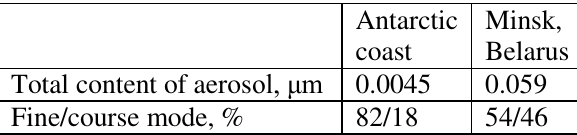
Table 1 Columnar concentrations of the aerosol